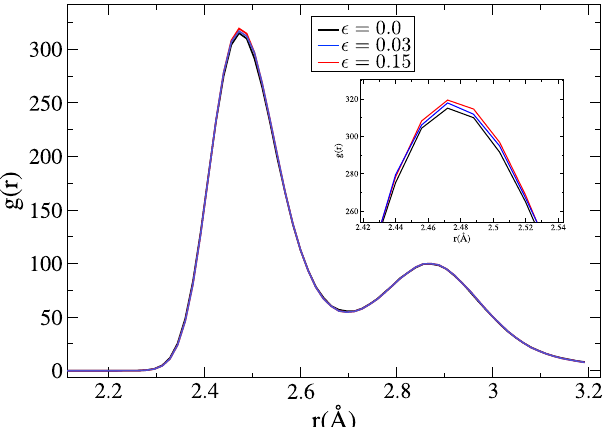
Figure 2. Pair correlation function for strains of 0, 0.03 and 0.15. Inset show a zoom of the g(r)